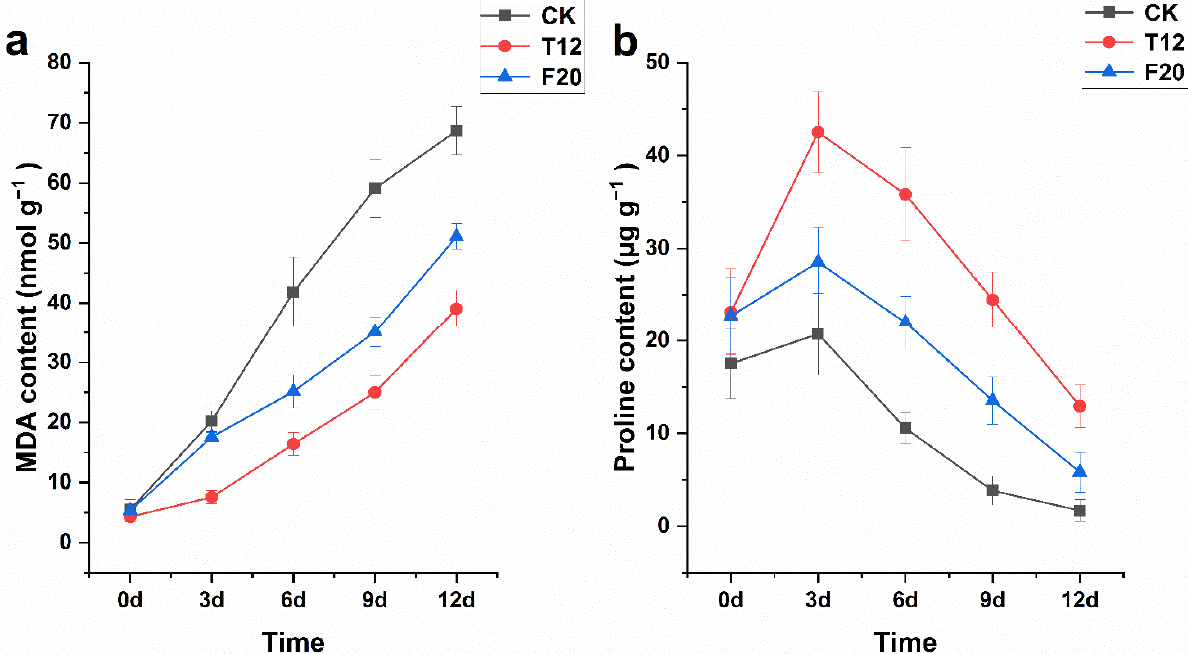
Figure 4. MDA and Proline content of CK, T12, and F20 before and under salt stress.